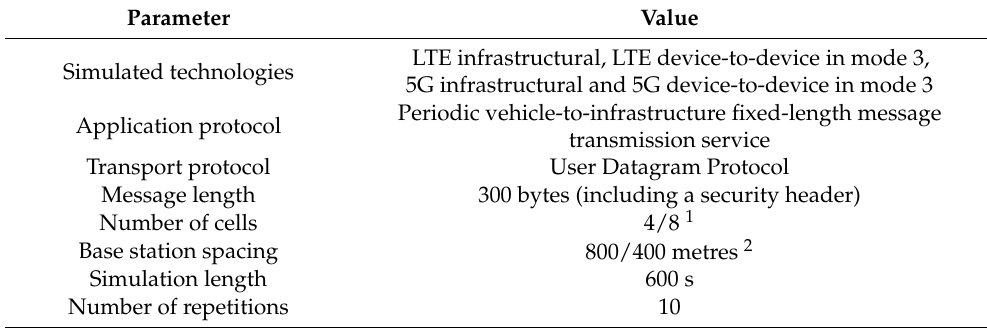
Table 1. Simulation scenario